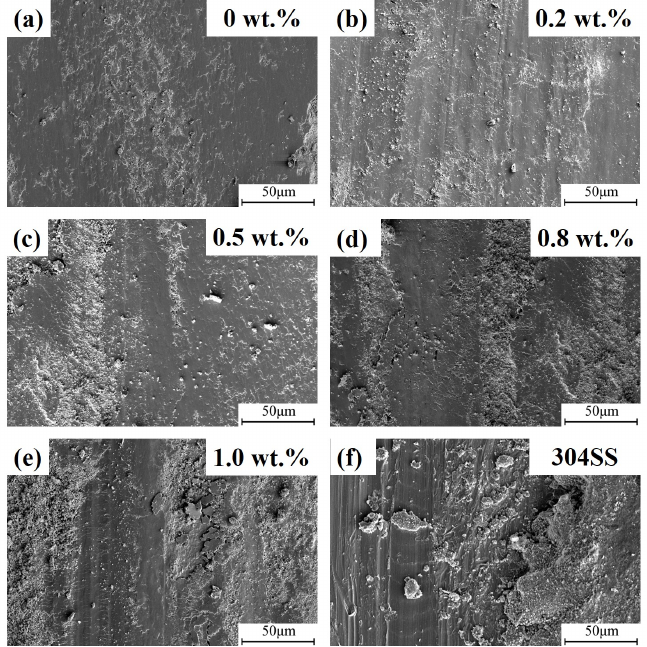
Figure 9. SEM images after wear test: ( a ) 0 wt.% Y 2 O 3 ; ( b ) 0.2wt.% Y 2 O 3 ; ( c ) 0.5 wt.% Y 2 O 3 ; ( d ) 0.8 wt.% Y 2 O 3 ; ( e ) 1.0 wt.% Y 2 O 3 ; ( f ) 304SS.